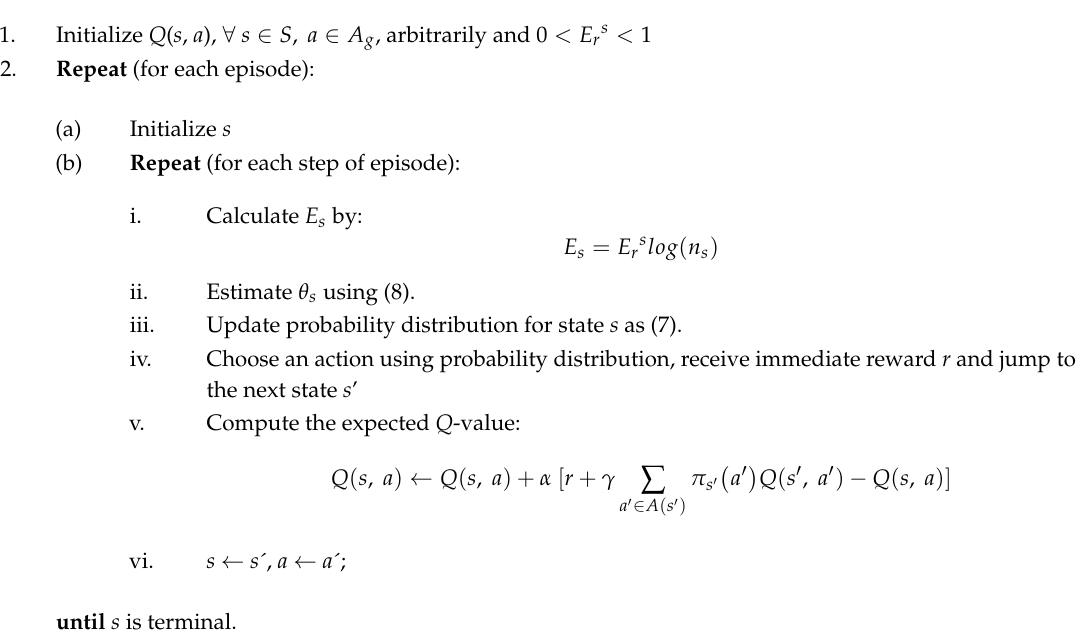
Algorithm 1: Modified SARSA algorithm: executed by all Gencos and Discos 1.